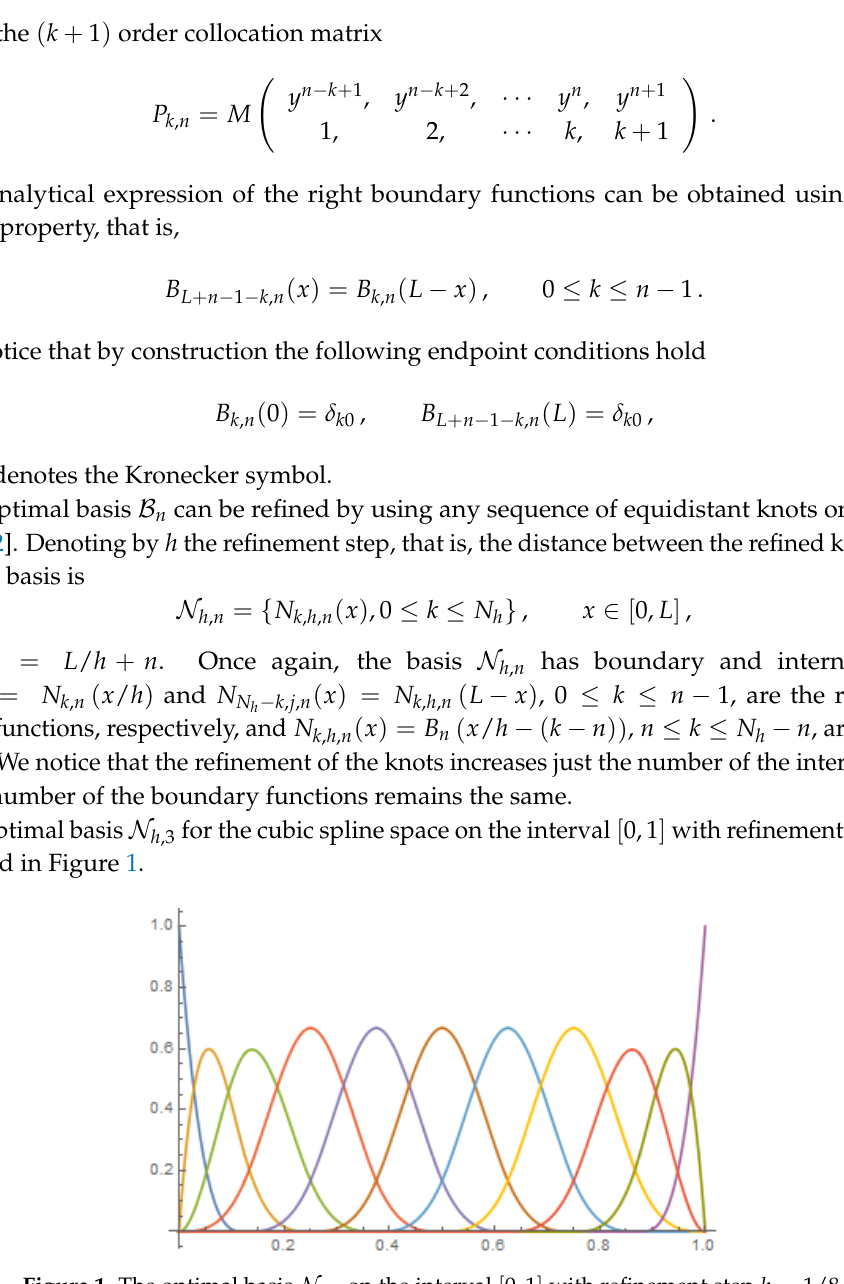
Figure 1. The optimal basis N h ,3 on the interval [ 0,1 ] with refinement step h =